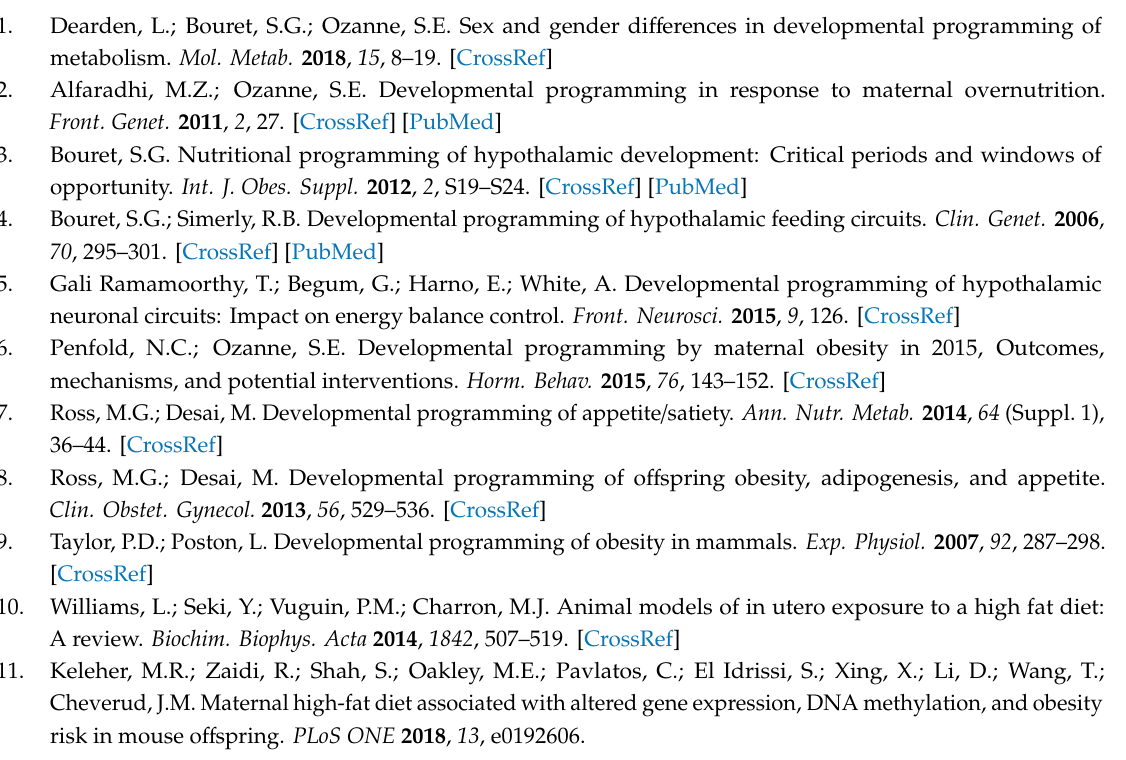
Table S1: RT-qPCR Gene Targets. Table S2: Maternal Relationship with Male O ff spring Energy Homeostasis. Table S3: O ff spring Energy Homeostasis Relationship with Hypothalamic Appetite